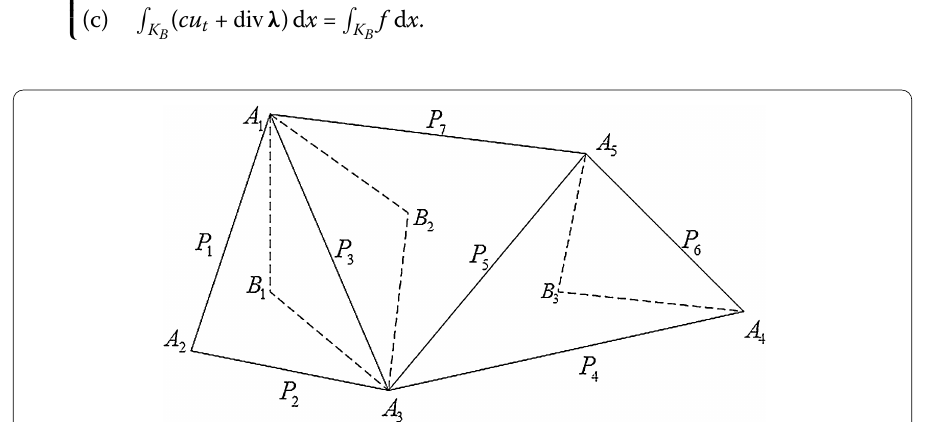
Figure 1 Primal and dual